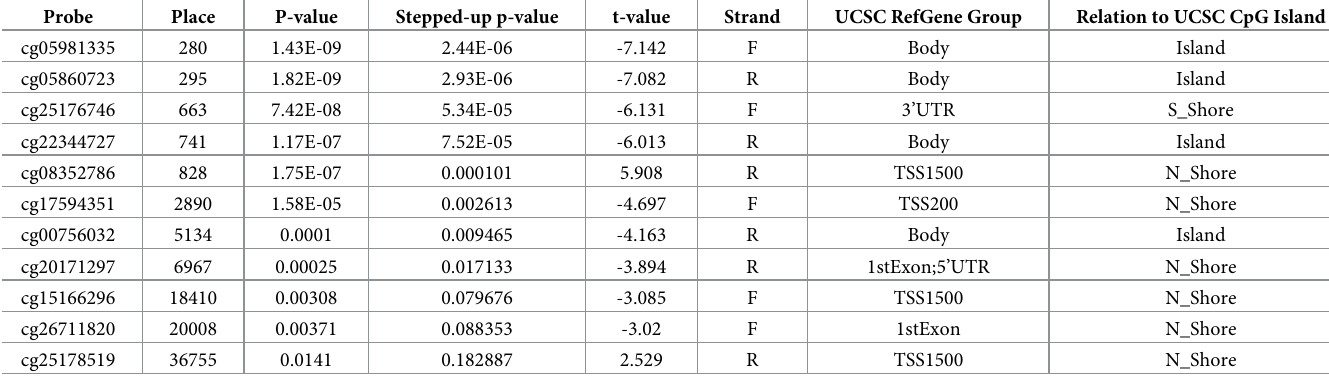
Table 5. Myf6 probes showing differences in methylation between HCL and HCLv.